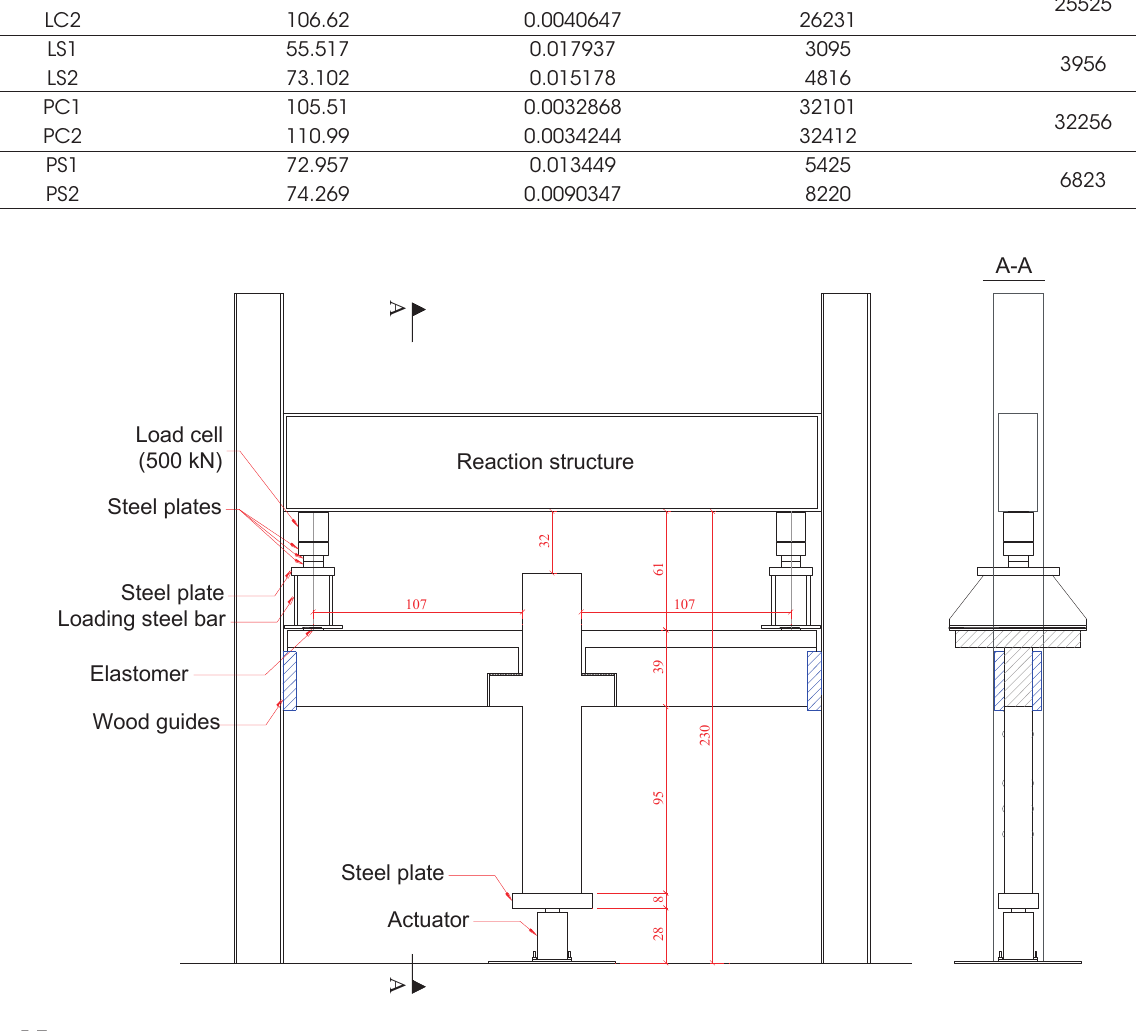
Figure 15 – Test setup for the specimens and reaction structure (dimensions in cm) Test setup for the specimens and reaction structure (dimensions in cm)